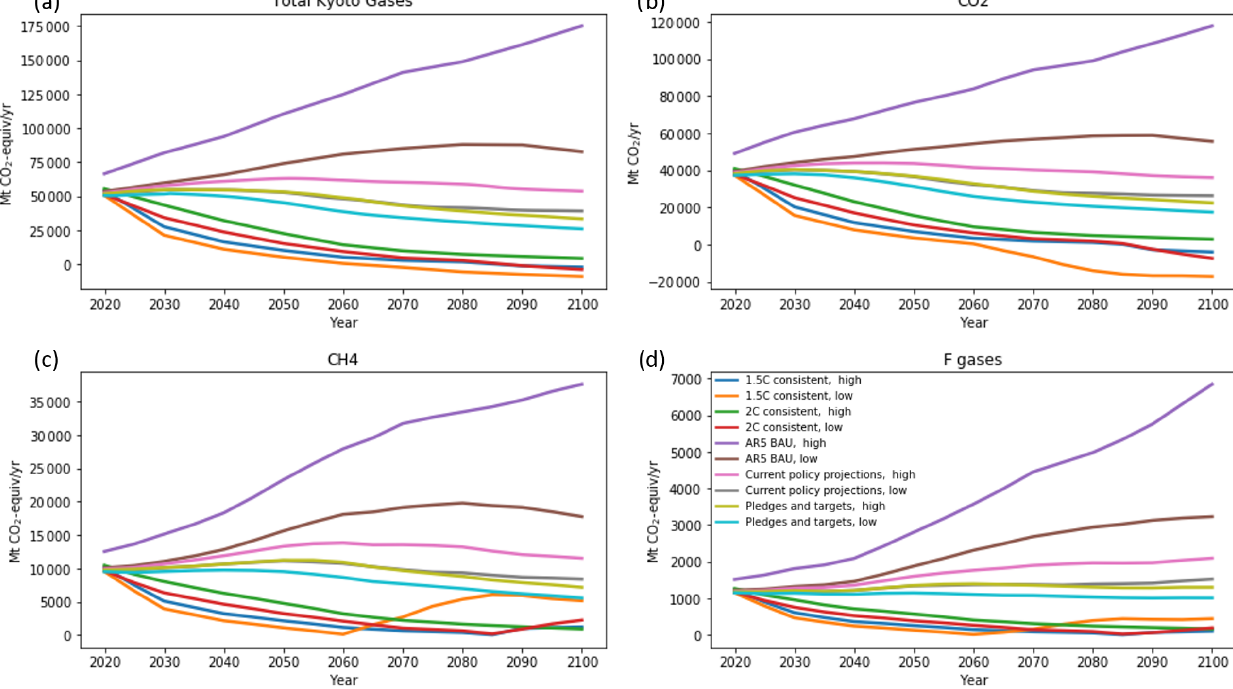
Figure 5. The CAT Kyoto gas baskets decomposed into their components using the decompose collection multiple infiller.